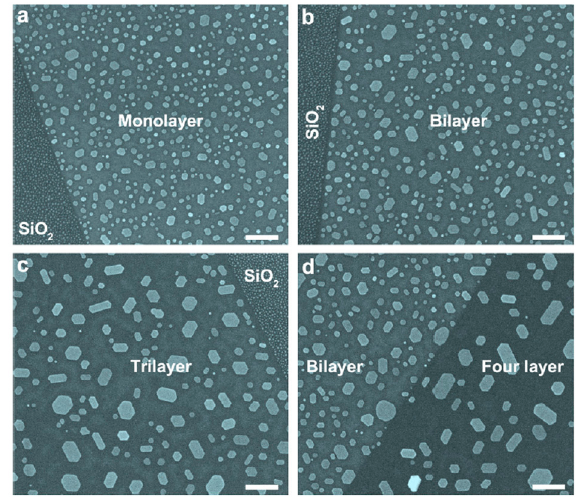
Figure 23. Scanning Electron Microscopy images showing the dewetting of Au films into hexagonal Au NPs on graphene after thermal annealing at 700 °C for 2 h. Film thickness: 2.0 nm. Scale bar: 200 nm. ( a ) Hexagonal Au NPs on SiO 2 ( left ) and monolayer graphene ( right ); ( b ) Hexagonal Au NPs on SiO 2 ( left ) and bilayer graphene ( right ); ( c ) Hexagonal Au NPs on trilayer graphene ( left ) and SiO 2 ( right ); ( d ) Hexagonal Au NPs on bilayer ( left ) and four layer graphene ( right ). Reproduced from Reference [68] with permission from Elsevier.